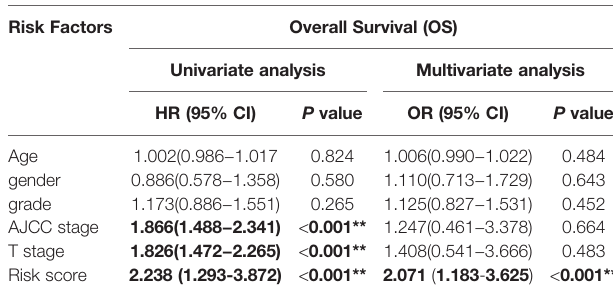
TABLE 3 | Univariate and Multivariate Cox regression analysis of survival associated